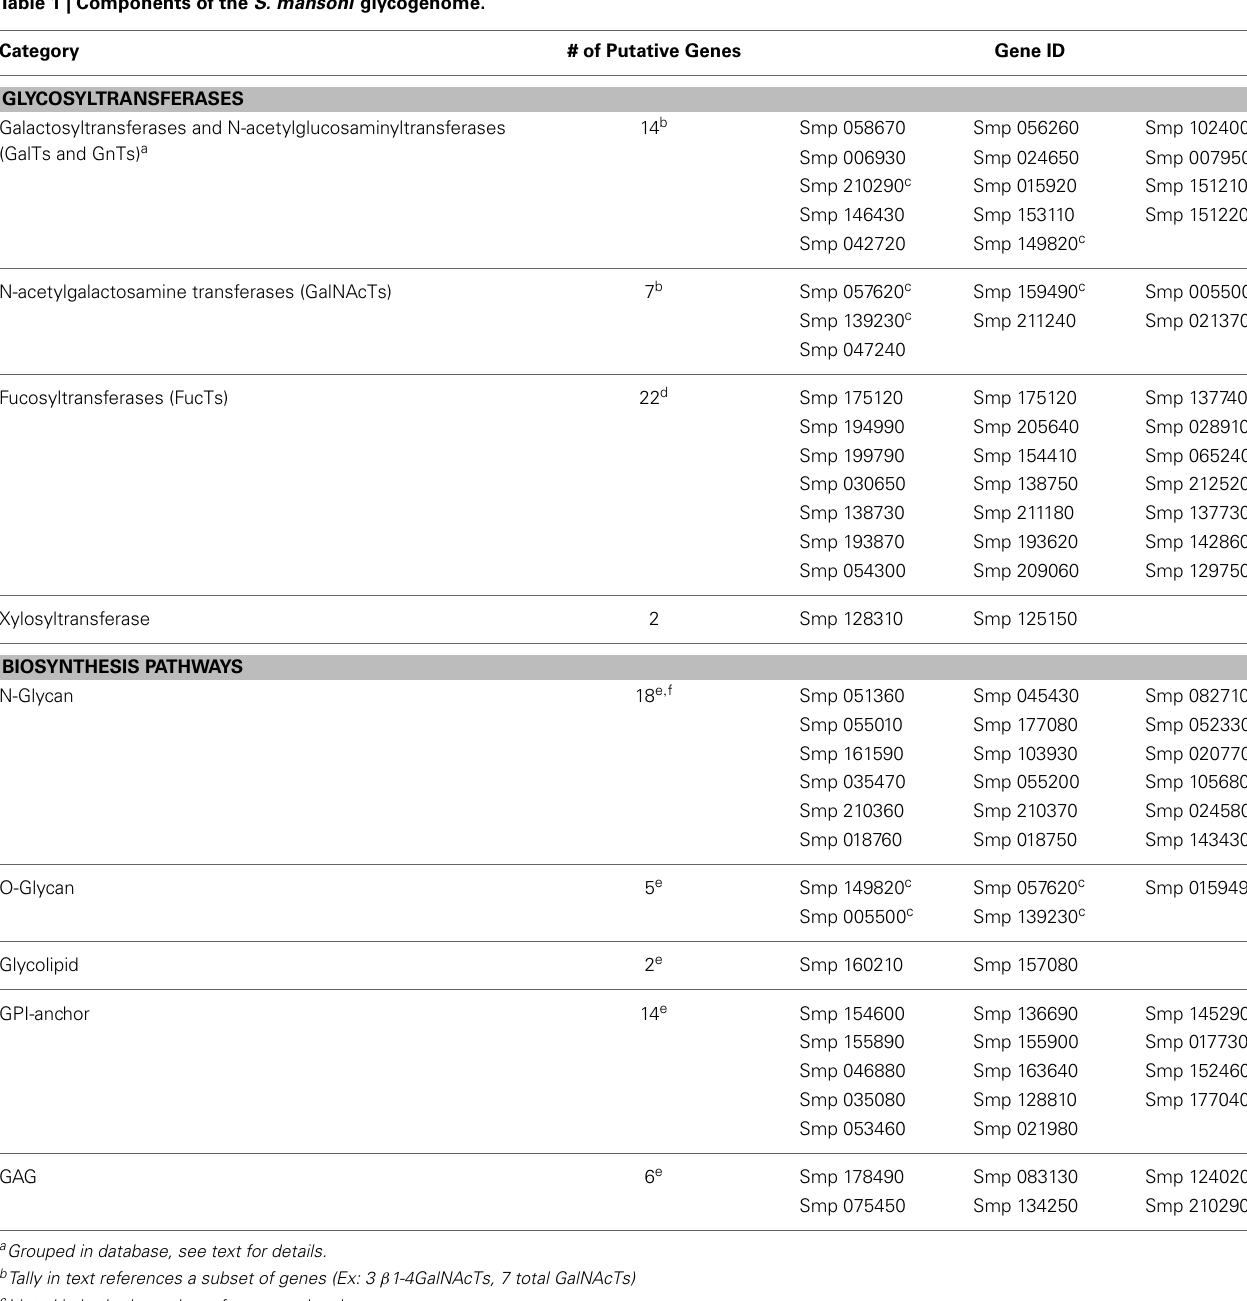
Table 1 | Components of the S. mansoni glycogenome. Category # of Putative Genes Gene ID GLYCOSYLTRANSFERASES Galactosyltransferases and N-acetylglucosaminyltransferases (GalTs and GnTs)